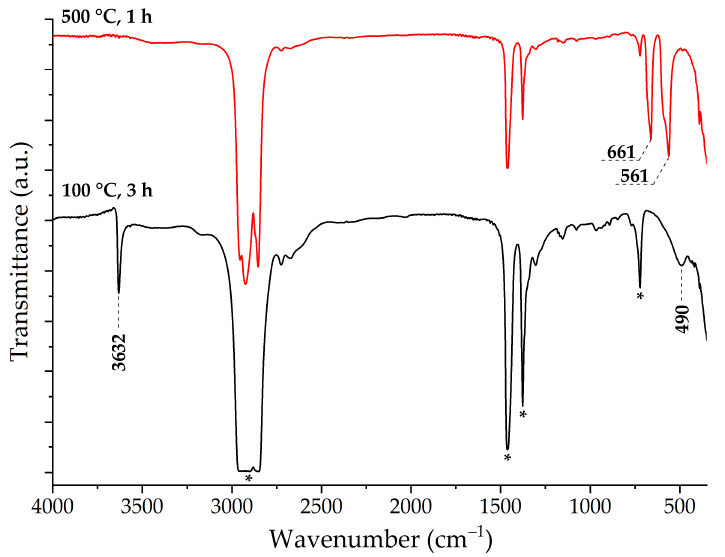
Figure 2. FTIR spectra of the obtained semi-product ( bottom ) and oxide powder ( top ); the marker “*” refers to the absorption bands of Vaseline oil.